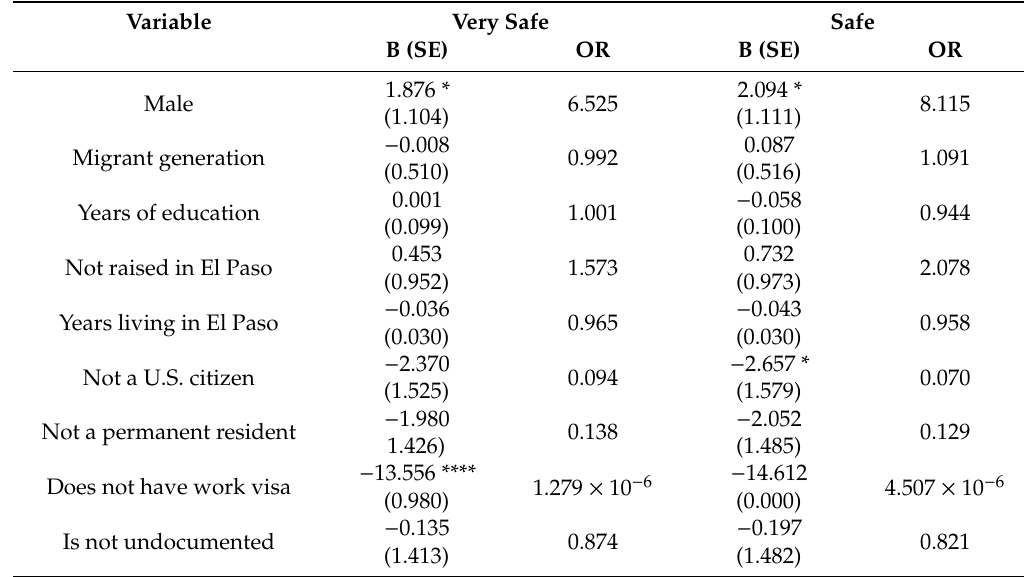
Table 4. Multinomial logistic regression